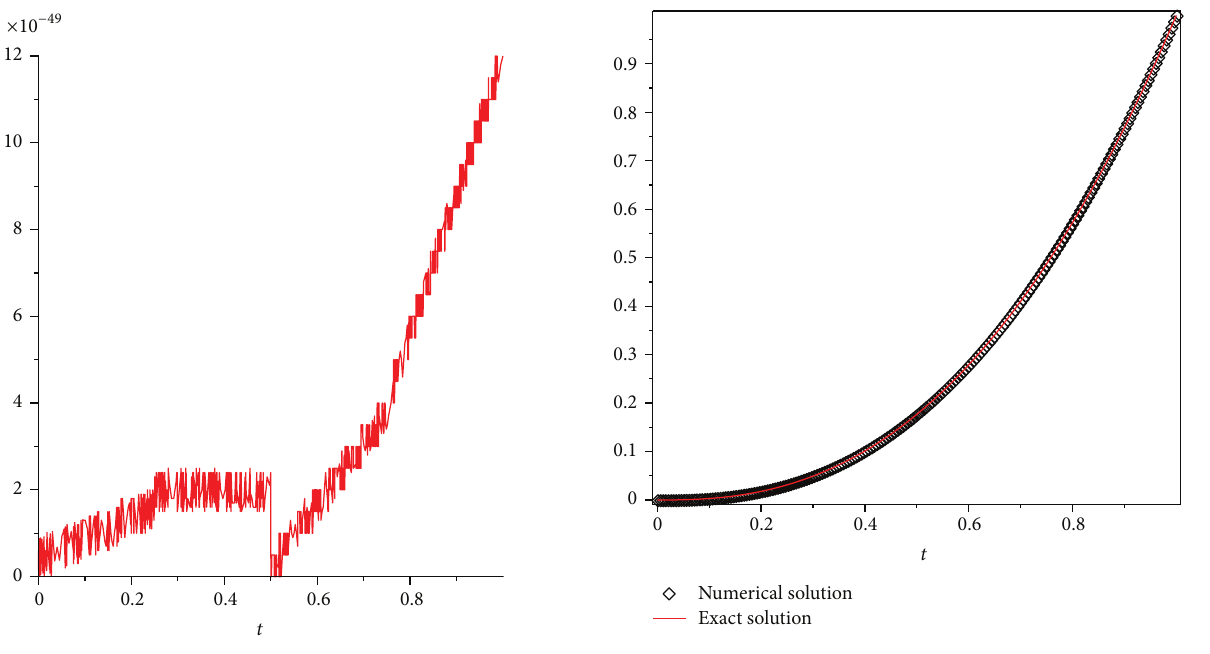
Figure 3: Absolute error for Example 2.